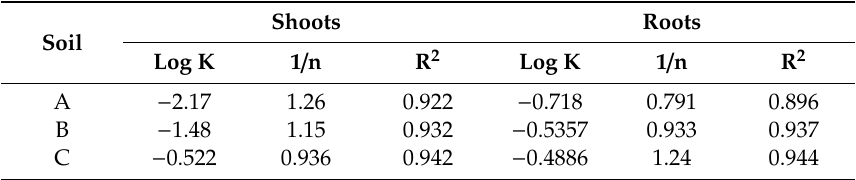
Table 4. Relationship between tungsten concentration in shoots and roots and tungsten concentration in soil. Parameters of the Freundlich-like model. Shoots Roots Soil Log K 1 /